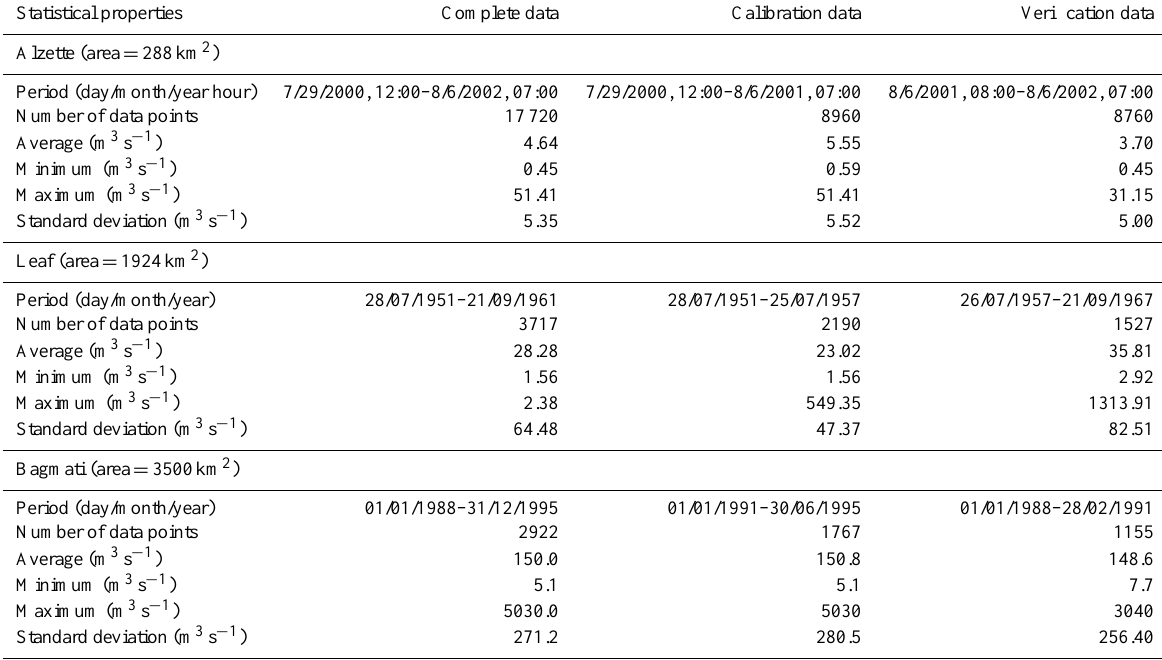
Table 1. The summary of the runoff data for Alzette catchment in Luxembourg, Leaf catchment in USA, and Bagmati catchment in Nepal. Statistical